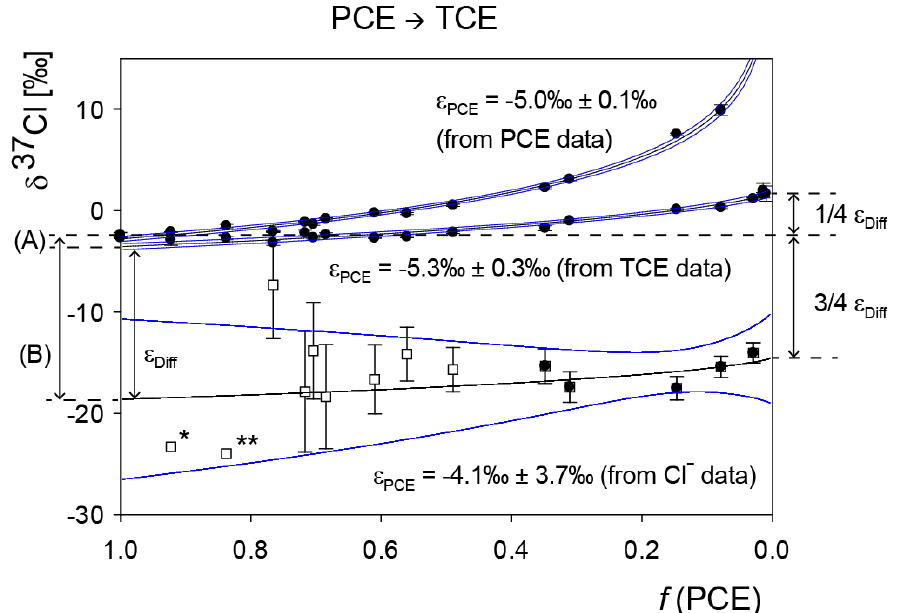
Figure 3. Chlorine isotope data of PCE degradation to TCE and chloride by Desulfitobacterium sp. strain Viet1 including fits in Sigma Plot according to the presented mathematical approach and 95% confidence intervals of the nonlinear regressions (for − were calculated by error propagation regression data see S.I.). Uncertainties for δ 37 Cl Cl , δ 37 Cl and f (PCE) (see S.I.). Resultant uncertainties including uncertainties in δ 37 Cl PCE TCE